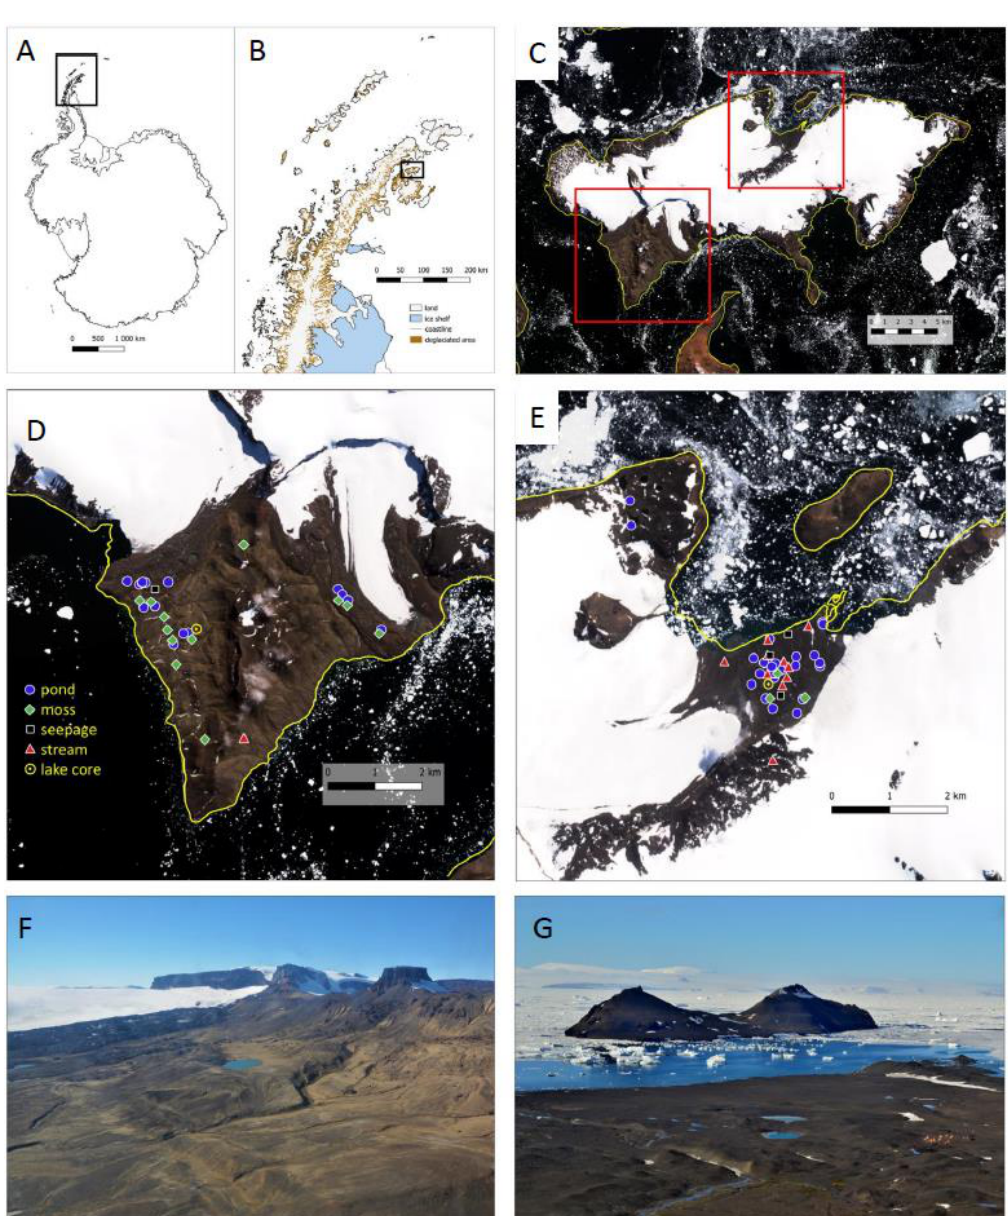
Figure 1. Map indicating the northern Antarctic Peninsula ( A ) and the location of Vega Island ( B ). To the right, a satellite image of Vega Island indicates the location of the two studied sites ( C ); Cape Lamb (southwest) and Devil’s Bay (northeast). Panels ( D ) and ( E ) provide an aerial view of Cape Lamb and Devil’s Bay, respectively, along with the location of sampled habitats from each side. Pond habitats are indicated by blue circles, moss habitats by green diamonds, seepages by black squares, streams by red triangles, and lake cores with a brown circle with a dot. The satellite picture was taken from Sentinel-2 (photo taken on 29 December 2018, RGB image based on Bands 8, 4, and 3). Lastly, Panels ( F ) and ( G ) are field photographs of Lake Esmeralda and Lake Anónima, respectively (photos by K. Kopalová and J. Kavan).